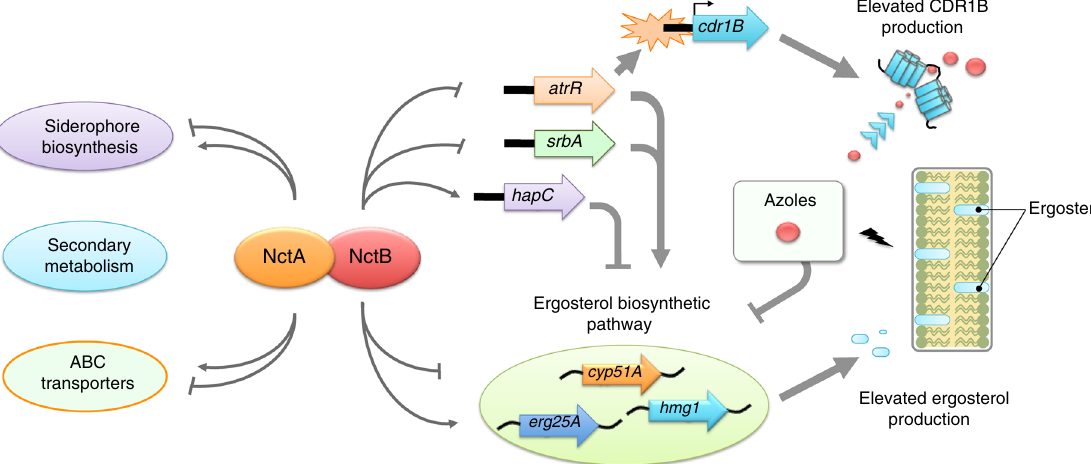
Fig. 9 Proposed model highlighting the mechanistic basis of the azole resistance in the NCT complex. The NCT complex is a global regulator, which acts as both a negative and a positive regulator of a wide range of gene regulation that includes secondary metabolism, cellular transport and sterol biosynthesis as important targets for virulence and azole resistance in A. fumigatus . The NCT complex fi ne-tunes expression of several genes in the ergosterol biosynthesis pathway and the azole ef fl ux pump encoding cdr1 by directly interacting with their core promoter region. The NCT complex also acts as a key regulator of azole resistance by modulating the expression levels of the transcription factors associated with ergosterol biosynthesis and azole resistance; transcriptional repression of the activator-encoding srbA and atrR genes , and activation of the negative regulator-encoding hapC gene . Therefore, the loss of the NCT complex causes an increased level of cellular ergosterol content and an elevated production of Cdr1B that leads to a multi-drug-resistance phenotype to the azoles as well as the salvage therapeutics amphotericin B and terbina fi